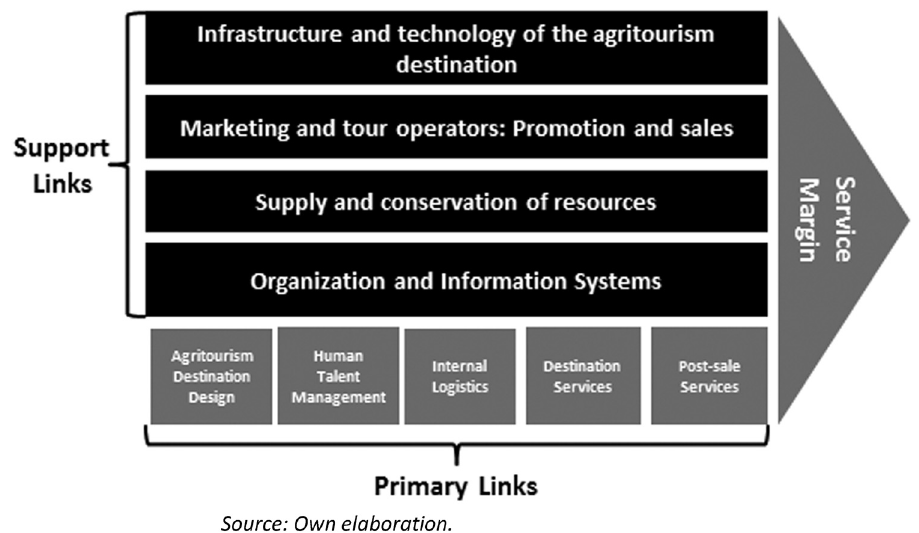
Figure 5: Value chain of agritourism destinations. Source: own